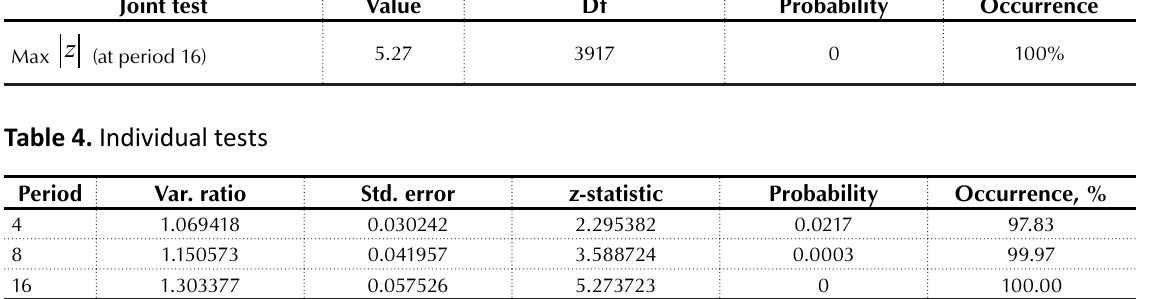
Figure 4 ensures the accuracy as Maximum Absolute Error (MAE) and Root Mean Square Error (RMSE) are considerably on the lower side (0.53 and 2.538, respectively).